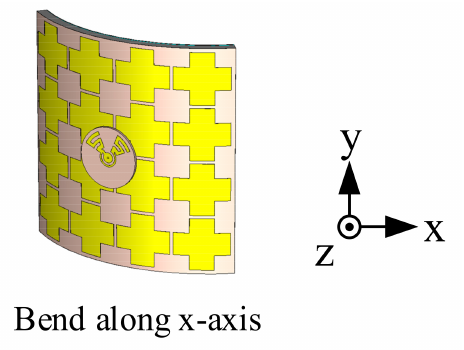
Figure 15. Bending over a cylinder along the x